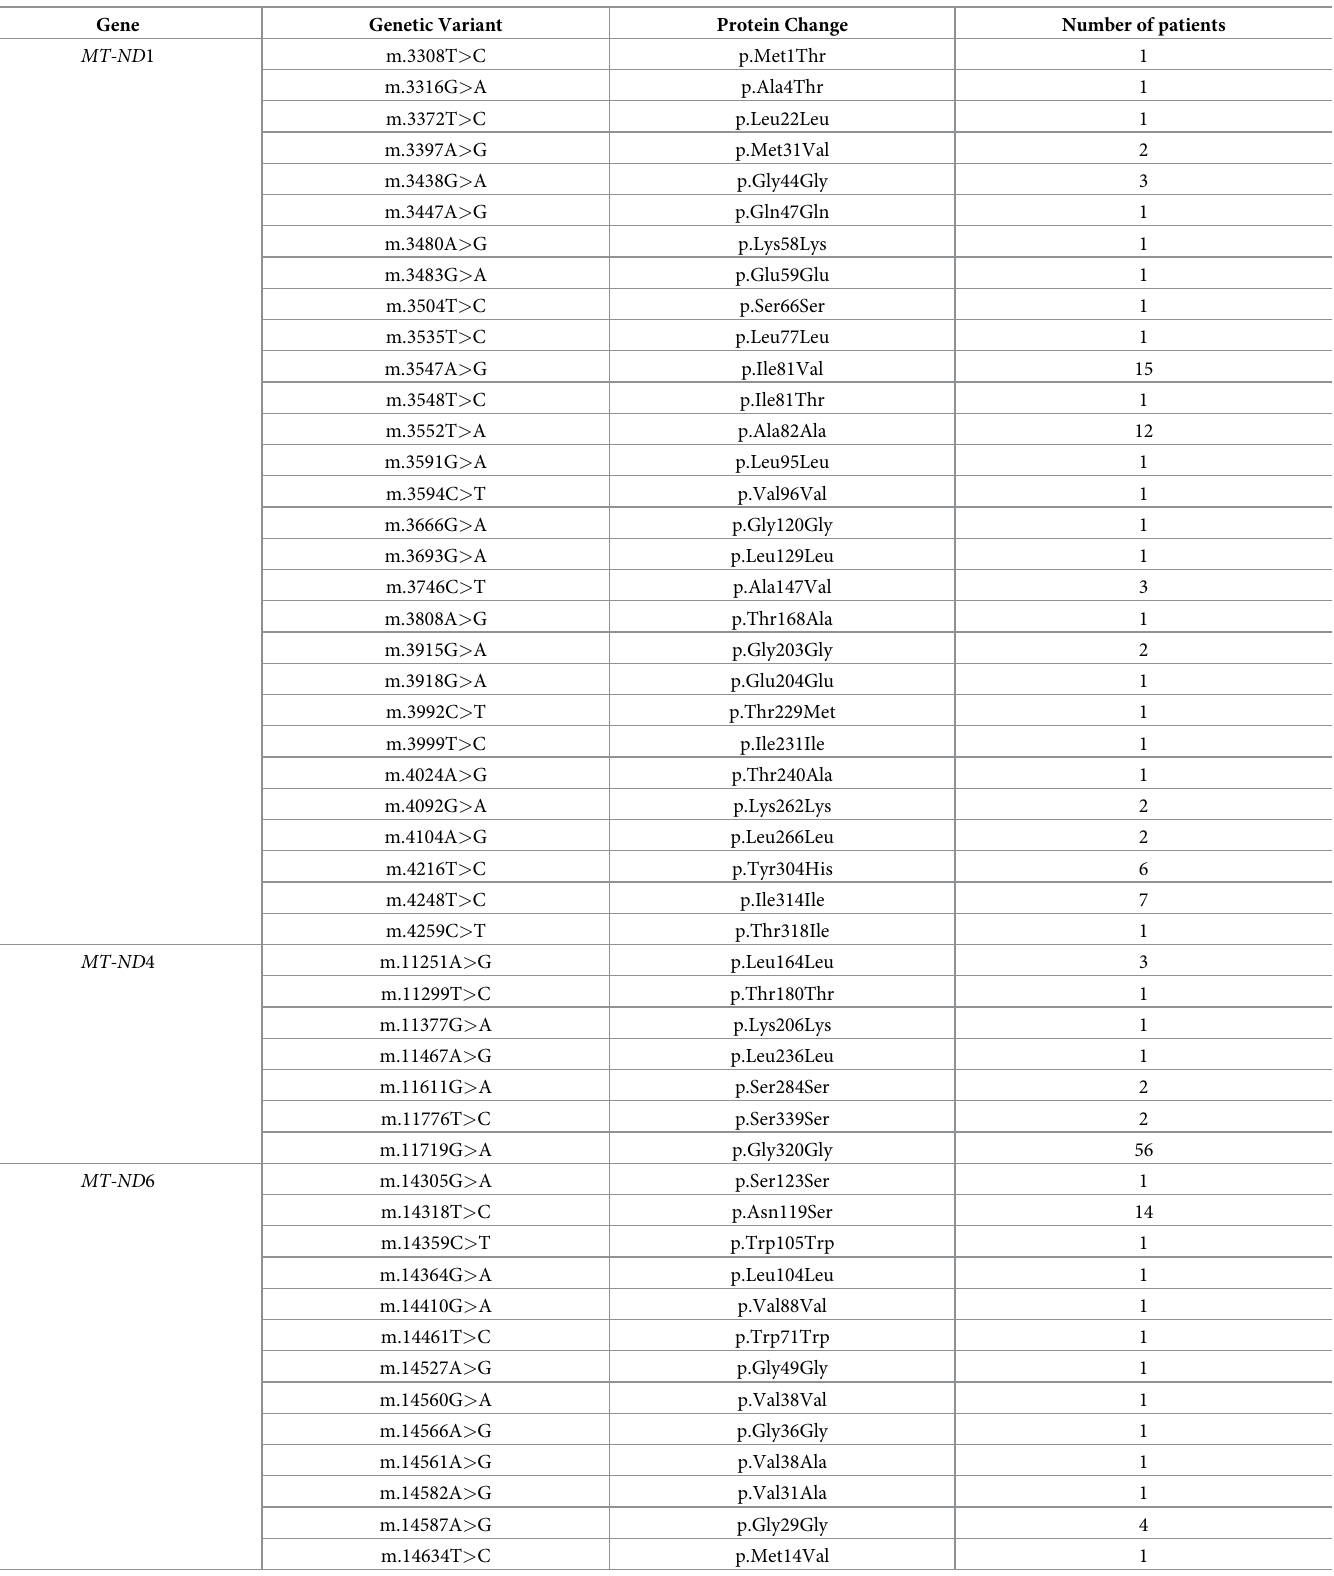
Table 4. Genetic variants reported as benign in MITOMAP detected in 100 patients